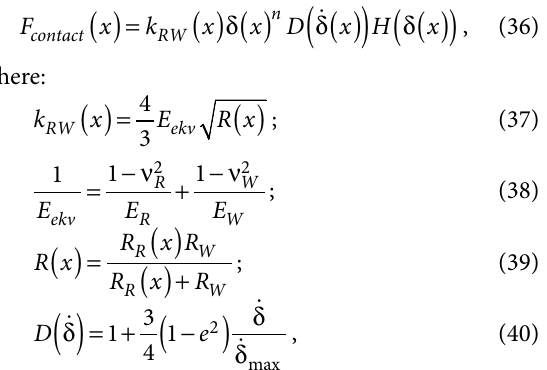
Fig. 4. The contact of the wheel and rail: a – changes in penetration in the contact area; b – chart of speed and forces operating at point k of the vehicle’s wheel and rail Force ( ) F x appearing at the contact point is contact determined using Hertzian contact theory . In addition, the hysteresis of contact forces is